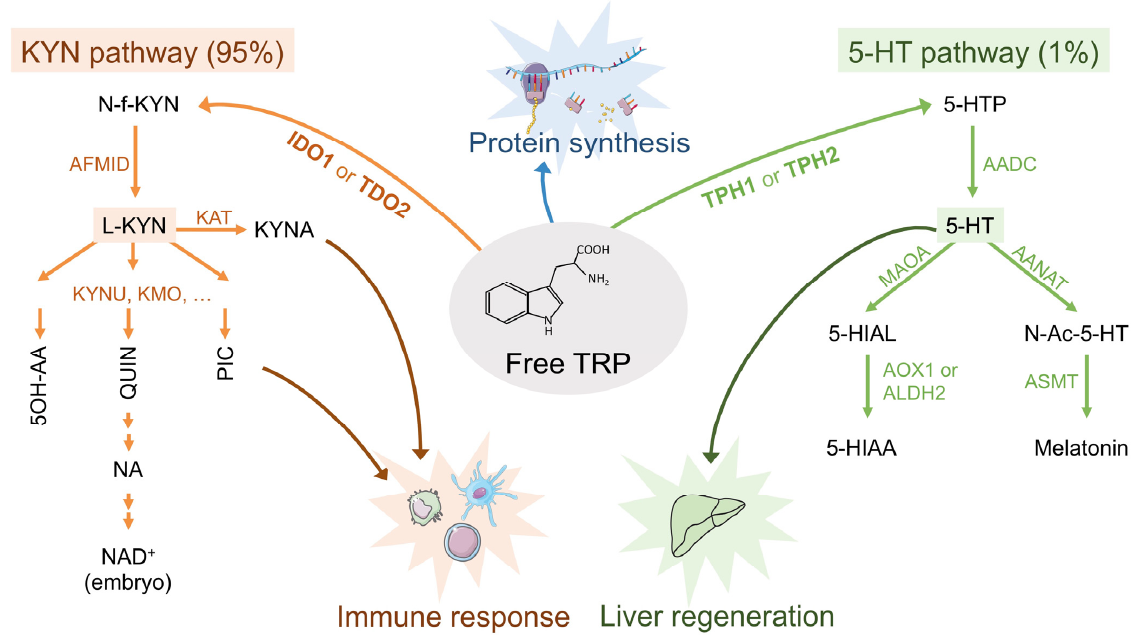
Figure 1. Free tryptophan cellular fate. The first and limiting step of the KYN pathway is catalyzed by tryptophan dioxygenase (TDO2) in the liver or indoleamine dioxygenase (IDO1/2) in immune cells. The first and limiting step of the 5-HT pathway is catalyzed by the tryptophan hydroxylase (TPH1). KYN pathway enzymes: IDO1/2, Indoleamine 2,3-dioxygenase 1/2; TDO2, tryptophan 2,3-dioxygenase; AFMID, arylformamidase; KYNU, kynureninase; KMO, kynurenine 3-monooxygenase; KAT, Kynurenine aminotransferase. KYN pathway metabolites: KYN, kynurenine; N-f-KYN, N-formylkynurenine; KYNA, Kynurenic acid; 5-OH-AA, 5OH-anthralinic acid; QUIN, quinolinic acid; PIC, picolinic acid; NA, nicotinic acid. 5-HT pathway enzymes: TPH1/2, Tryptophan 5-hydroxylase 1/2; AADC, Aromatic- L -amino-acid decarboxylase; MAOA, monoamine oxidase A; AANAT, aralkylamine N-acetyltransferase; AOX1, aldehyde oxidase 1; ALDH2, aldehyde dehydrogenase 2; ASMT, acetylserotonin O-methyltransferase. 5-HT pathway metabolites: 5-HTP 5-hydroxytryptophan; 5-HT, serotonin; 5-HIAL, 5-hydroxyindole acetaldehyde; 5-HIAA, 5-hydroxyindole acetate; N-Ac-5-HT, N-acetyl